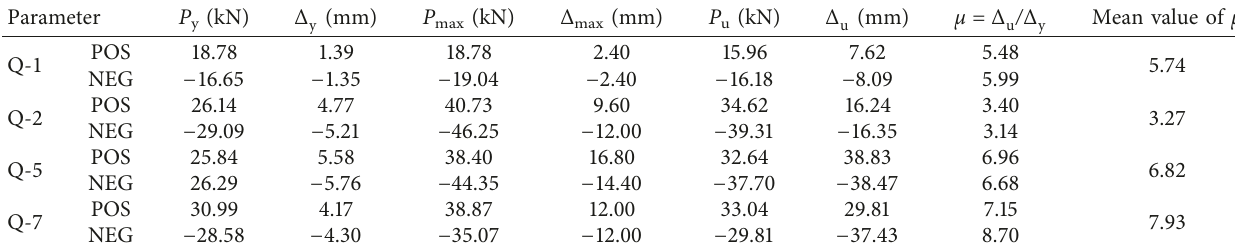
Figure 10: Comparison of skeleton curves of specimens. Table 4: Global displacement ductility values of test specimens.